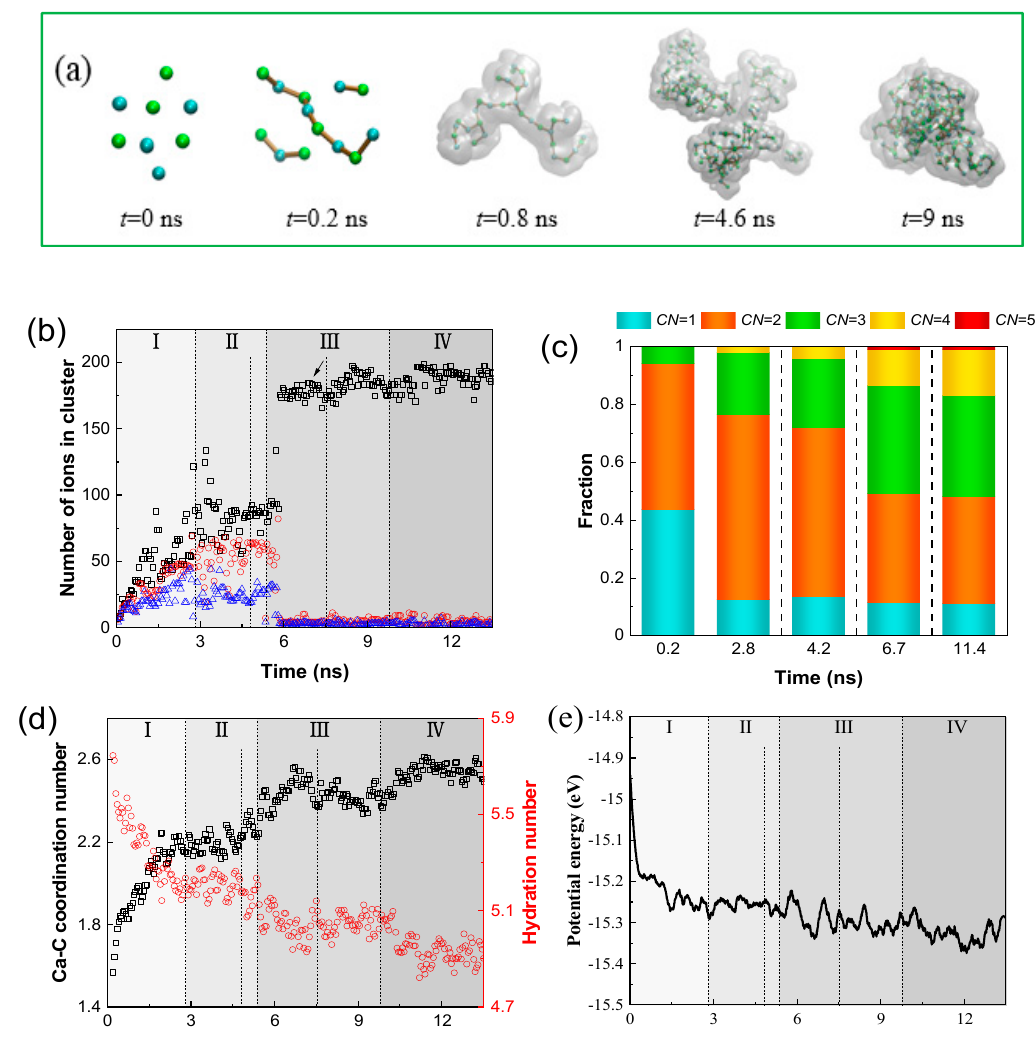
Figure 2. ( a ) MD simulations snapshots for PNCs growth and aggregation in the aqueous solution with 0.96 mol/L CaCO 3 at 360 K. The green, cyan, and gray colors represent Ca 2+ , CO 32 − , and hydration shell, respectively. The final cluster by PNCs aggregation is referred to as “aggregate”. ( b ) Evolution of the number of ions in the three largest clusters. The black, red, and blue represent the first, second, and third large-size clusters, respectively. The nucleation instant is marked with an arrow. ( c ) Fraction of coordination number CN = 1–5 of Ca-C pairs at various instants. ( d ) Evolution of Ca-C coordination number and hydration number for Ca ions in the PNCs or aggregate. ( e ) Evolution of potential energy of calcium ions in the PNCs or aggregate.